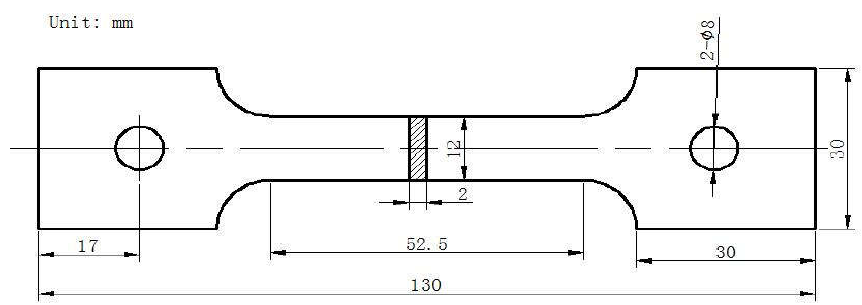
Figure 2. Configuration of tensile test sample.